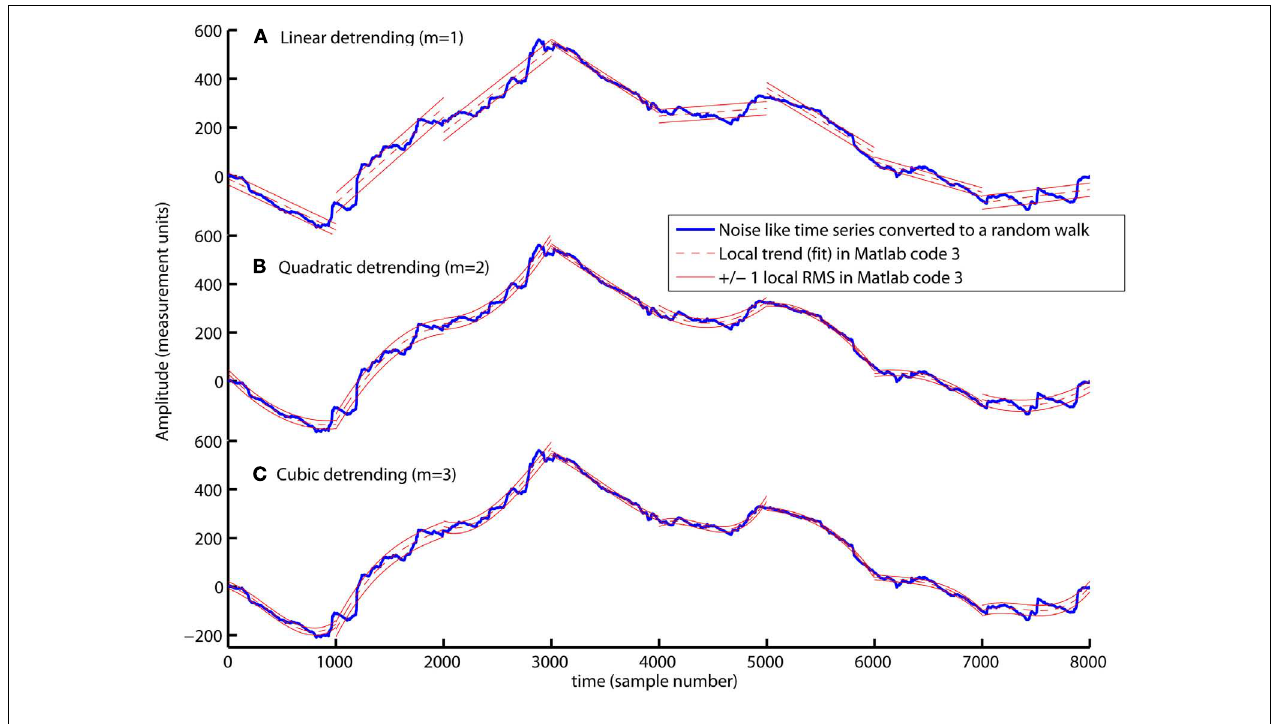
1000.The distance between the red dashed trend and the solid red lines represents ± 1 RMS{1} .The local fluctuation, RMS{1} , around trends is the basic “building block” of the detrended fluctuation analysis